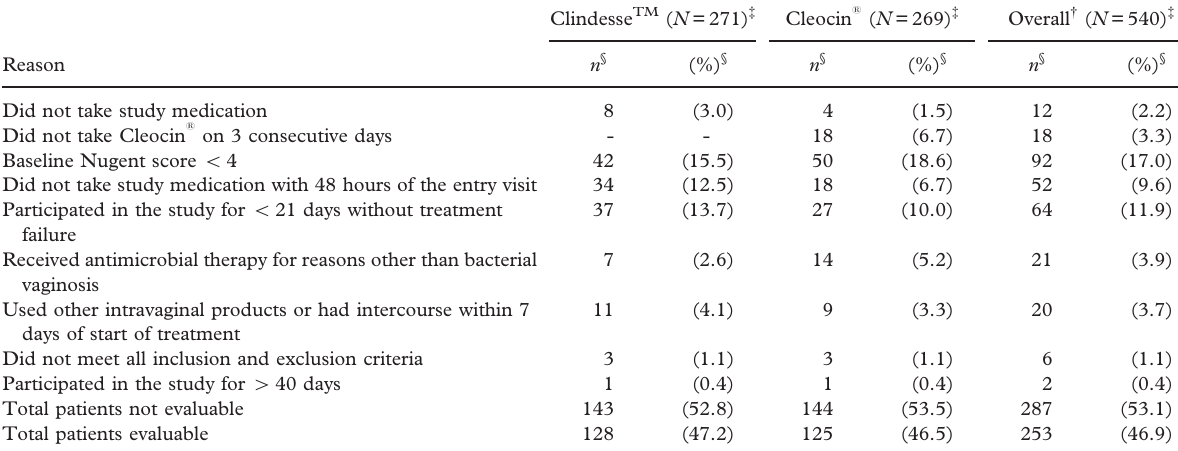
Table I. Primary reasons for non-evaluability in the per-protocol population by treatment